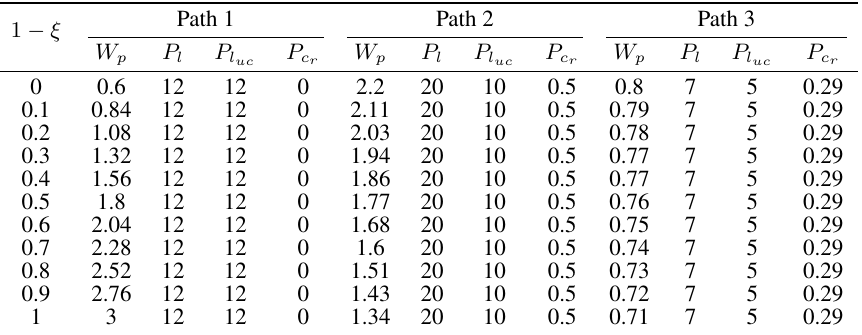
Table 3. Three different navigation paths.